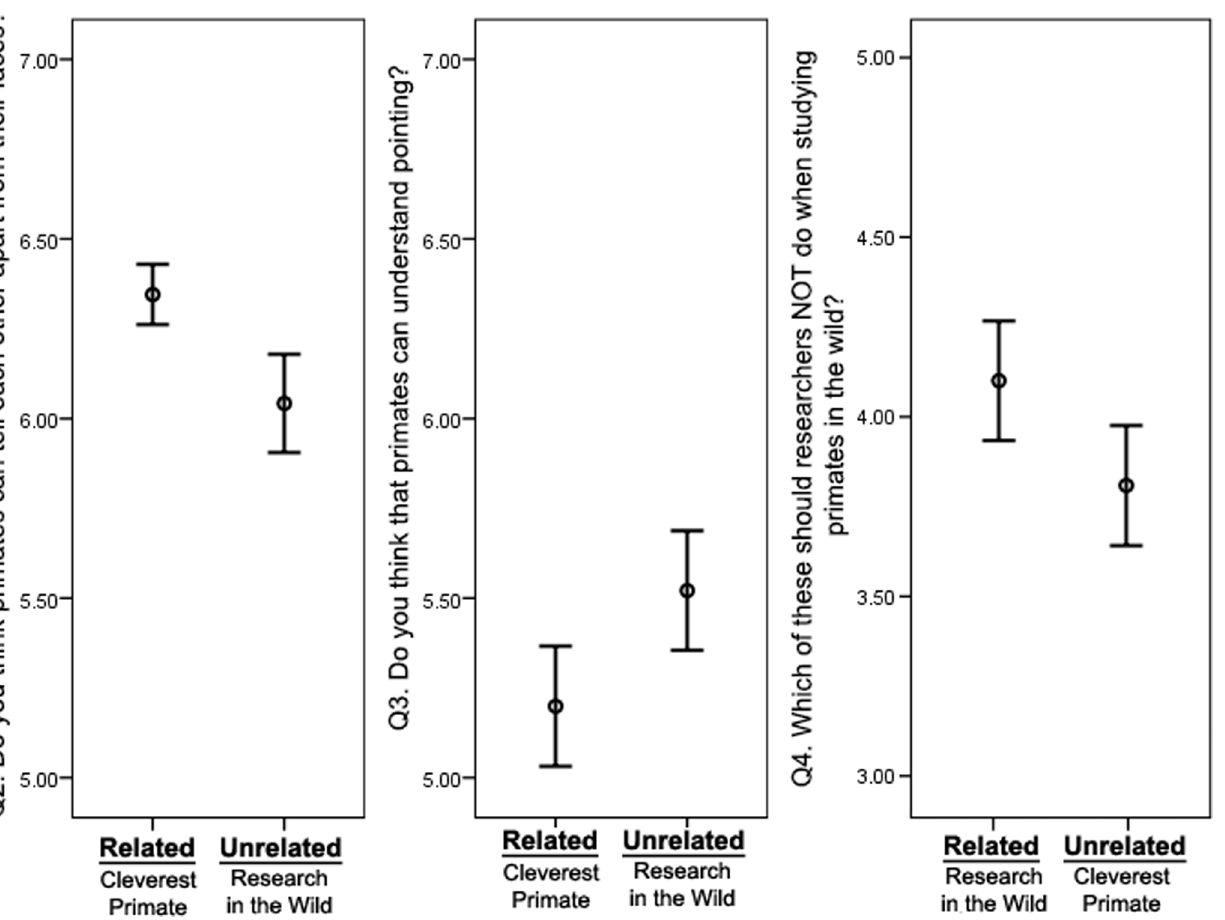
Figure 2. Questionaire responses 2–4. Question responses (mean ¡ SE) of individuals who interacted with the touchscreen. The questions related to topics explained in one game (related game) but not the other (unrelated game). If they had learned correctly, visitors should respond with a higher score in Q2 (primates can tell each other apart from their faces), a lower score in Q3 (primates can’t understand pointing), and a higher score in Q4 (that humans should not feed, touch or sneeze near wild